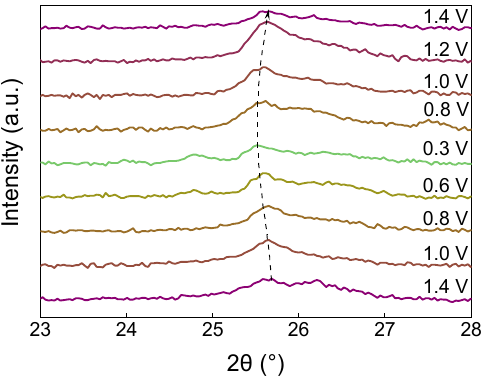
Figure 10. Ex situ XRD patterns of VO@PEDOT electrode upon the first discharge–charge cycle at 23–28°. The XPS spectra of O 1s and V 2p (Figure 11a), and Zn 2p (Figure 11b) obtained for VO@PEDOT electrodes in fully discharged (0.3 V) and fully charged (1.4 V) states after